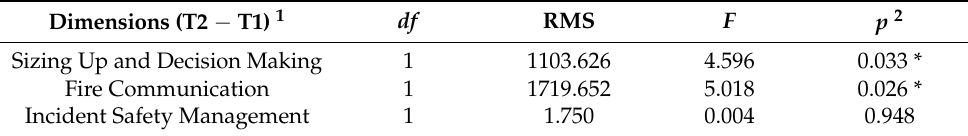
Table 7. Variance analysis of progress before and after the epidemic